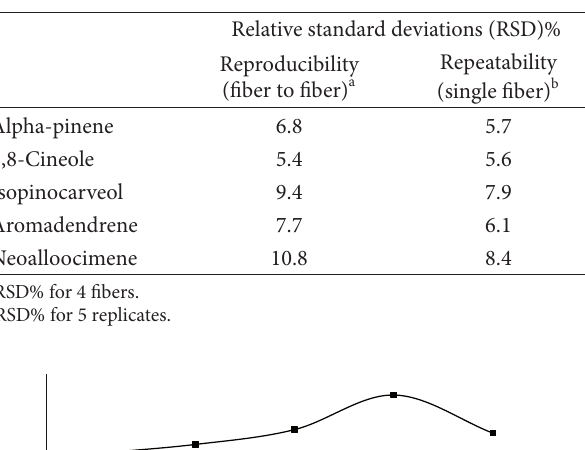
T 2: Repeatability and reproducibility using nanoparticle-